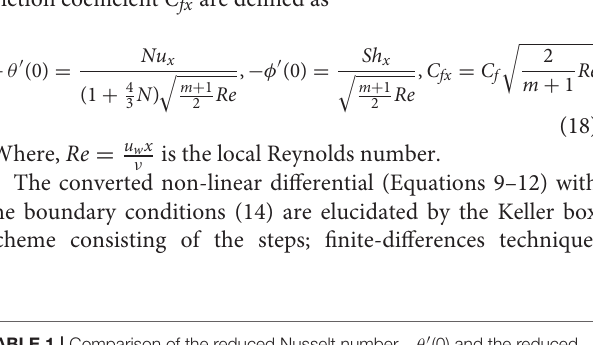
TABLE 1 | Comparison of the reduced Nusselt number − θ ′ (0) and the reduced Sherwood number − θ ′ (0) when M , N = 0, β → ∞ , δ , Sr , Df , λ = 0, m = 1, Pr = Le = 10 and γ = 90 ◦ .